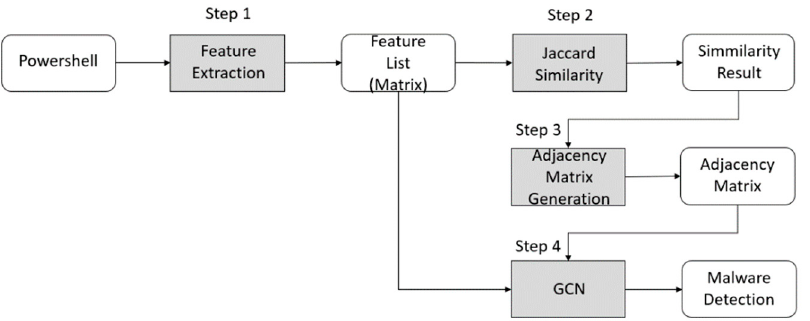
Figure 3. Malicious powershell detection using GCN.